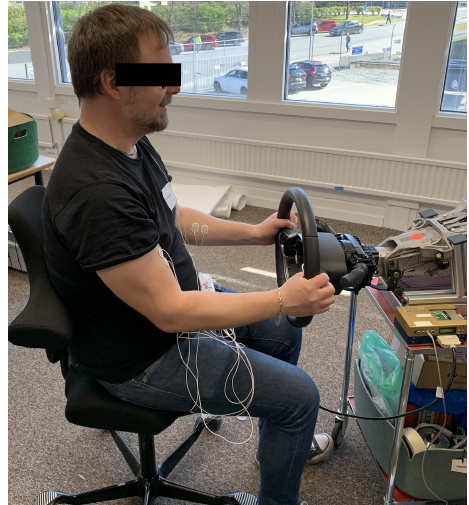
Figure 4. Participant holding the steer in quarter-to-three hand to steering wheel